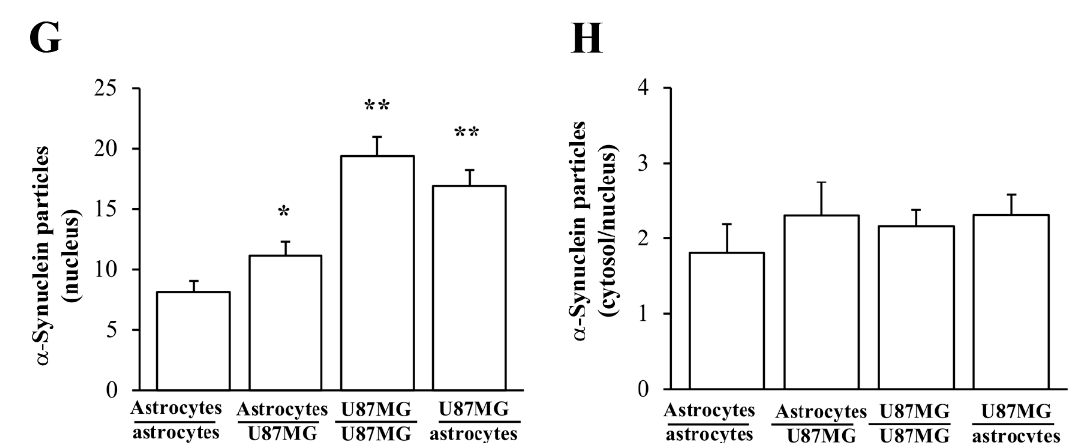
Figure 4. α -Syn increases within astrocytes co-cultured with GBM cells. Representative micrographs show α -syn immuno-gold particles within cytoplasm and nucleus (black arrows) of astrocytes (also representative of astrocytes co-cultured with astrocytes) ( A ); astrocytes co-cultured with GBM cells ( B ); GBM cells (similar to GBM cells co-cultured with other GBM cells ( C ), which replicates findings on GBM cells co-cultured with astrocytes ( D ). N = nucleus. The cell population under examination is the first one listed in the co-culture (i.e., astrocytes when examining a co-culture of astrocyte with GBM; or GBM when examining a co-culture of GBM with astrocytes). Such an explanation is needed in order to specify, which cell culture is specifically observed and quantified for each measurement. Graphs report the number of α -syn immuno-gold-particles within whole cell ( E ), cytosol ( F ), and nucleus ( G ). The ratio of α -syn immuno-gold particles within cytosol vs. nucleus is reported in ( H ). Data are given as the mean ± S.E.M. from N = 30 cells per each experimental group. * p < 0.05 compared with astrocytes co-cultured with astrocytes; ** p < 0.05 compared with astrocytes co-cultured with GBM cells. Scale bar = 1 µ